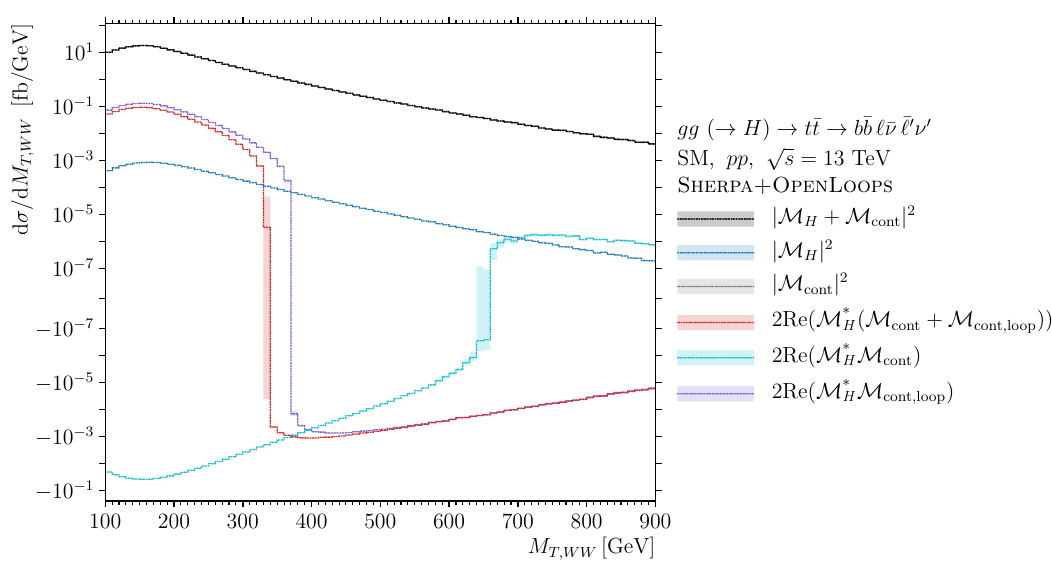
¯ t b ¯ b (cid:26) ¯ ν ¯ (cid:26) (cid:31) ν (cid:31) in the SM including →